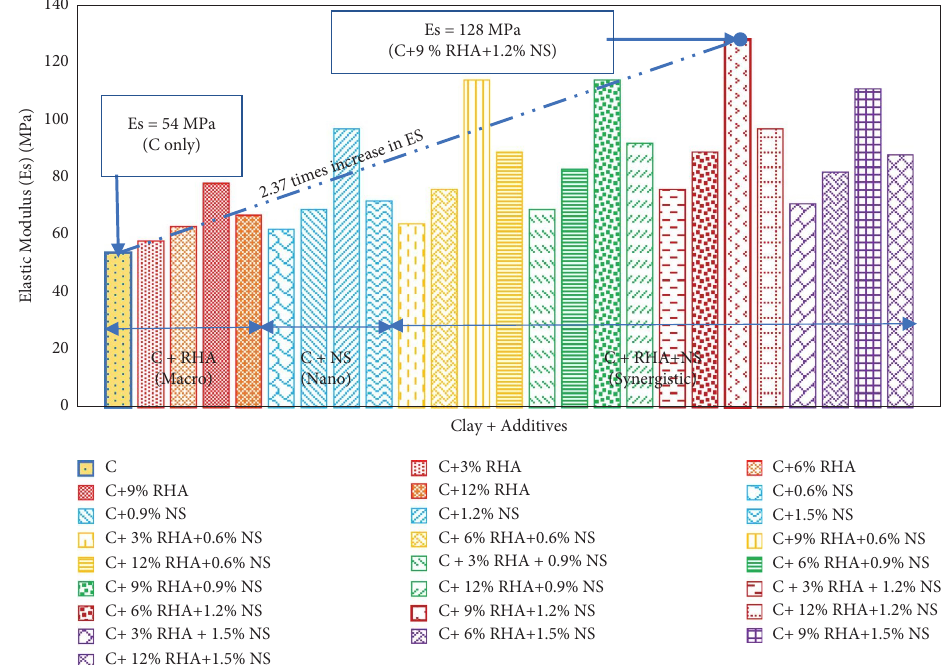
Figure 6: Es of clay and blends of clay plus RHA and NS.